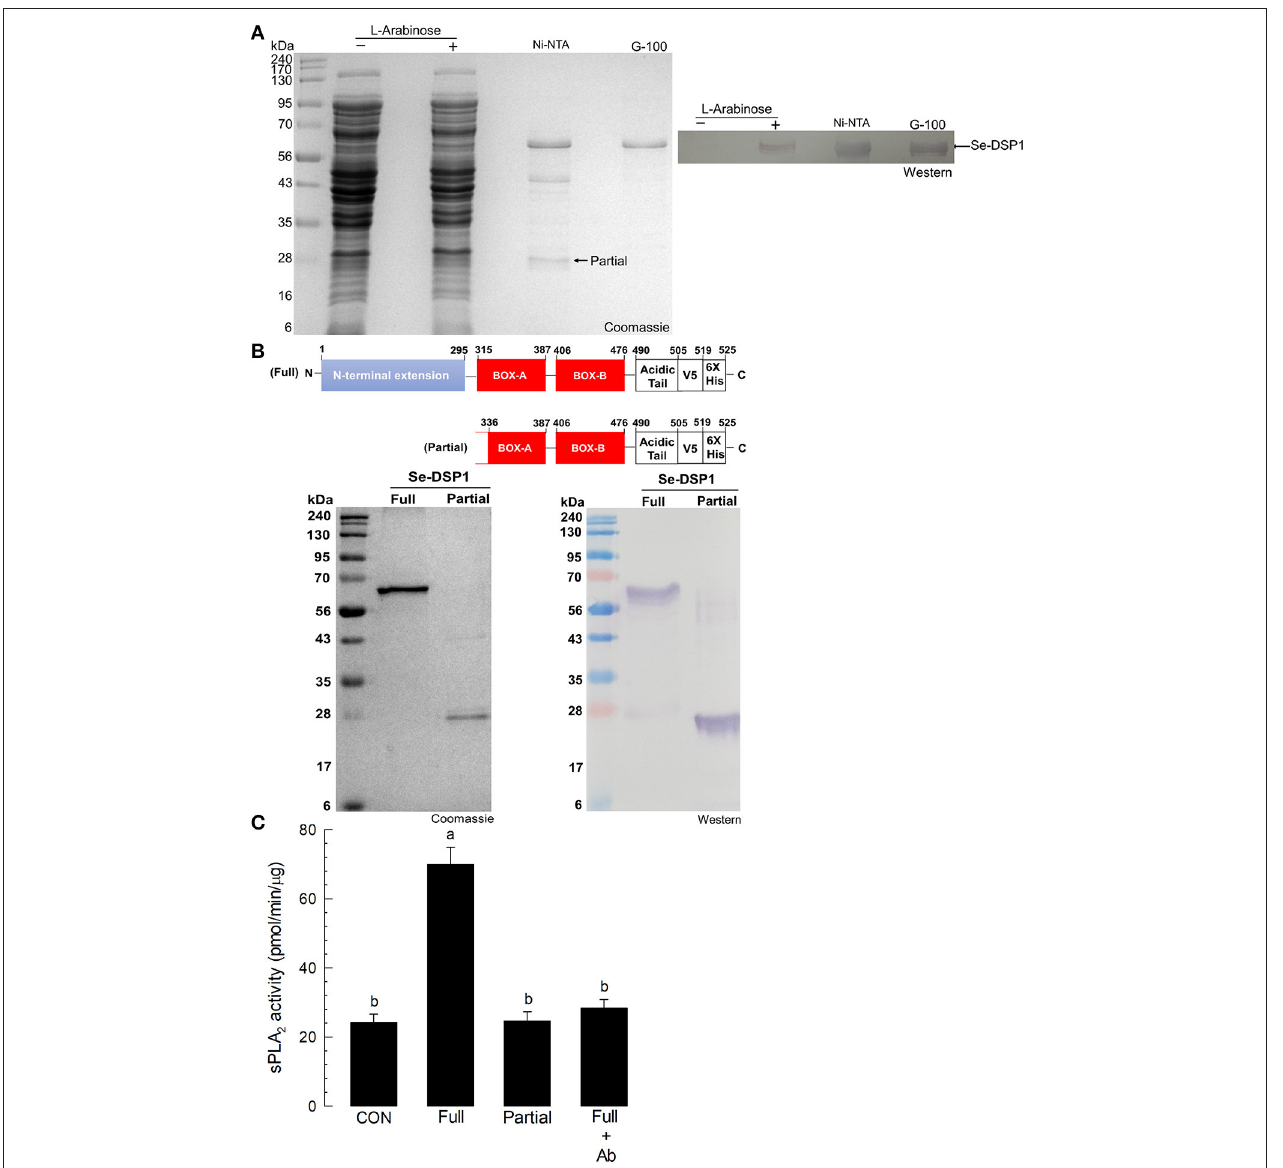
FIGURE 4 | The activation of fat body PLA 2 enzyme activity by Se-DSP1. (A) The purification of recombinant Se-DSP1 by affinity chromatography (“Ni-NTA”) and size-exclusion chromatography (“G-100”). The purified protein was confirmed with a monoclonal antibody specific to the V5 tag of the recombinant Se-DSP1 by Western blotting. (B) the purification of partial Se-DSP1. A comparison of protein domains between full and partial Se-DSP1. The partial protein was confirmed in its sequences by liquid chromatography with tandem mass spectrometry (LC-MS/MS) ( Supplementary Figure S4 ). (C) The upregulation of the sPLA 2 activity of S. exigua larvae by injecting a full length of Se-DSP1 (1 µ g/larva). The enzyme activity in the fat body was measured 8h after the injection. Partial Se-DSP1 was injected in the same amount. Control (“CON”) represented the phosphate-buffered saline (PBS) injection. An antibody (“Ab”) addition (2 µ l/larva) used a commercial polyclonal antibody that recognized Se-DSP1. Each treatment was replicated three times. Different letters above SD bars indicate a significant difference among means at Type I error = 0.05 (LSD test).